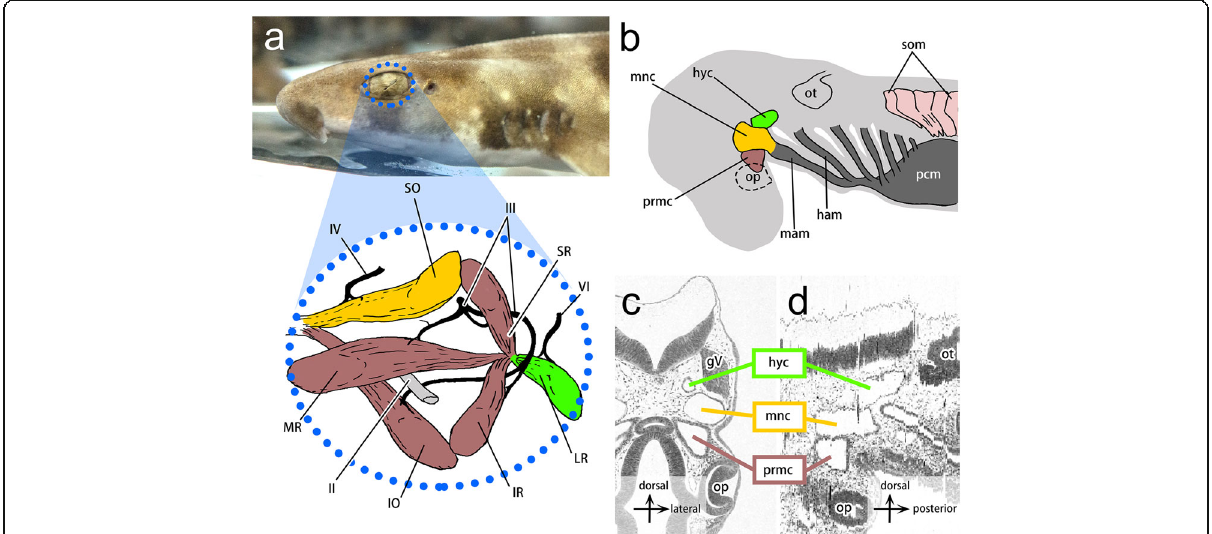
Fig. 1 Anatomy of EOMs and distributions of head cavities in the shark embryo. a Left lateral view of an adult shark ( S. torazame ; top) and schematic drawing of the left extraocular muscles (bottom). Sets of EOMs innervated by the same cranial motor nerve are shown in the same color: EOMs innervated by the oculomotor nerve in brown, by the trochlear nerve in orange, and by the abducens nerve in green. The blue dotted line indicates the outline of the left eye. b A schematic drawing of the left lateral view of the shark embryo at st. 25 showing the positional relationships of head cavities (HCs) to the pharyngeal and cardiac mesoderm (dark gray) and somites (light pink). Each HC is marked in the same color as sets of EOMs in ( a ), which are predicted to be derived from a single HC. c , d H&E sections in the transverse section ( c ) and the sagittal section reconstructed from serial transverse sections ( d ), showing the anatomical position of HCs, which are arranged in series dorsoventrally ( c ) and anteroposteriorly ( d ). The scheme in ( a ) is modified from ref. [1]. II, optic nerve; III, oculomotor nerve; IV, trochlear nerve; VI, abducens nerve; gV, trigeminal ganglion; ham, hyoid arch mesoderm; IO, inferior oblique muscle; IR, inferior rectus muscle; LR, lateral rectus muscle; mam, mandibular arch mesoderm; mnc, mandibular head cavity; MR, medial rectus muscle; op, optic cup; ot, otic vesicle; pcm, pericardial mesoderm; prmc, premandibular head cavity; SO, superior oblique muscle; som, somite; SR, superior rectus